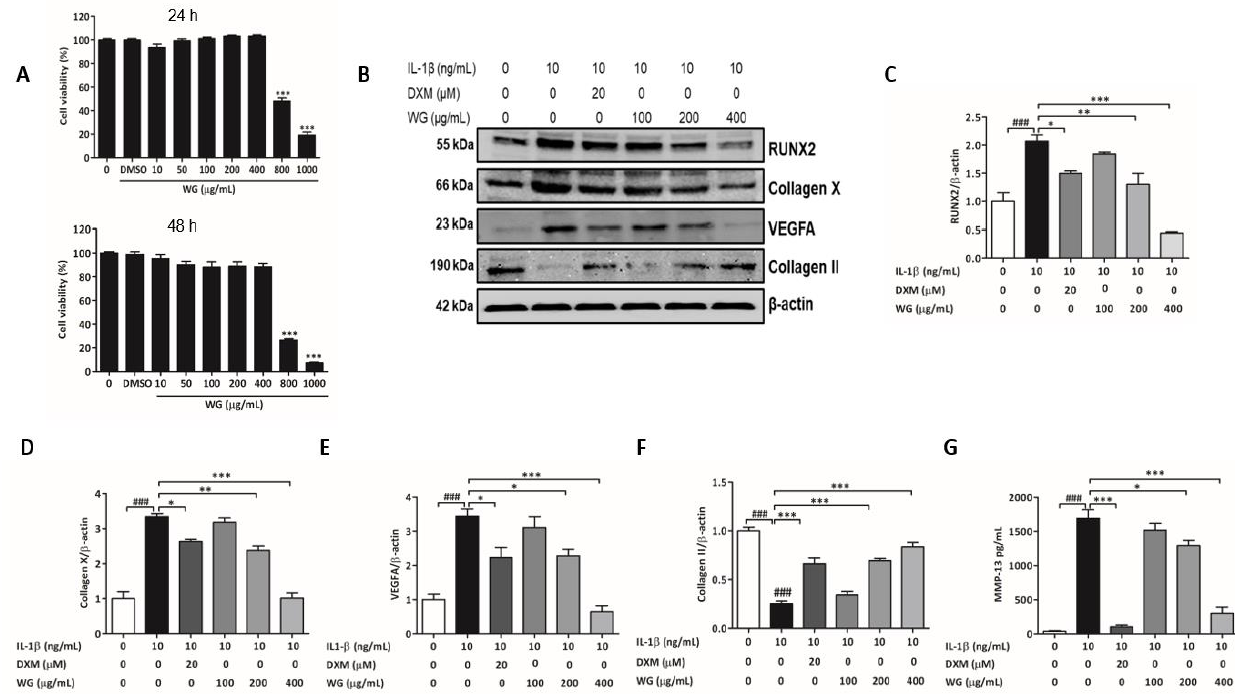
Figure 2. Cytotoxicity and effects of WG against IL-1 β -induced hypertrophic changes. ( A ) The cytotoxicity of WG on chondrocytes was determined at different concentrations using MTT assay. ( B ) Protein expression and quantitative analysis of ( C ) RUNX2, ( D ) Collagen X, ( E ) VEGFA, and ( F ) Collagen II expression relative to β -actin. ( G ) MMP-13 production was determined by ELISA. SW1353 cells were pretreated with indicated concentration of WG or DXM for 4 h followed by IL-1 β for 24 h. Data shown represent mean ± SEM ( n = 3). (### p < 0.001, vs. control; * p < 0.05, ** p < 0.01, and *** p < 0.001 vs. IL- 1β).